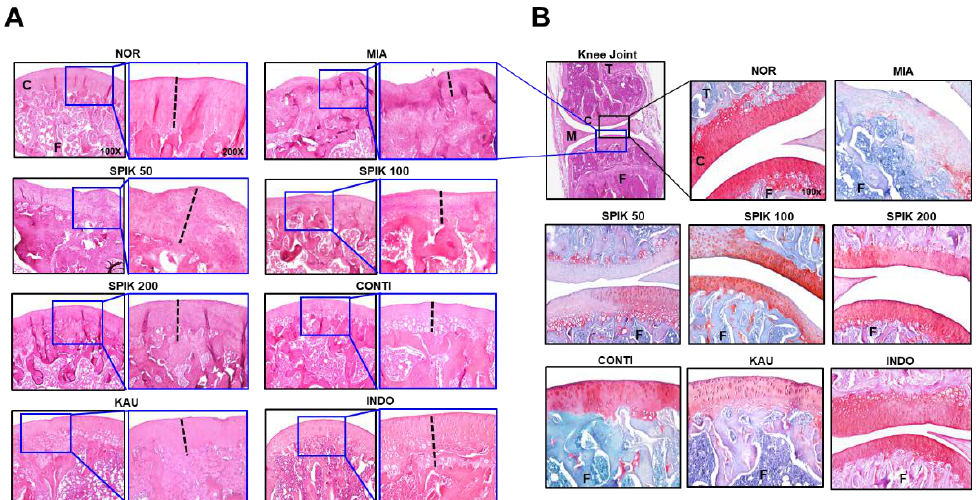
Figure 6. Histological images of rat’s knee joints using hematoxylin-eosin (H&E, A ) and safranin O-fast green (S–F, B ) staining solution. In Figure A , small blue squares in left photos (100 × ) are magnified to the right photos (200 × ) in each group. Dotted black lines in the right photos indicate the thickness of femur cartilage. Histological images in SPIK 50, SPIK 100 and SPIK 200 groups were from the rats orally administrated not intraperitoneally injected. In Figure B, first image shows the whole knee joint including femur (F), tibia (T), cartilage (C) and meniscus (M), and the blue and black squares indicate the anatomical regions for H&E and S–F staining, respectively. MIA, monoiodoacetate; SPIK, Manchurian spikenard extract; CONTI, continentalic acid; KAU, kaurenoic acid; INDO, indomethacin.